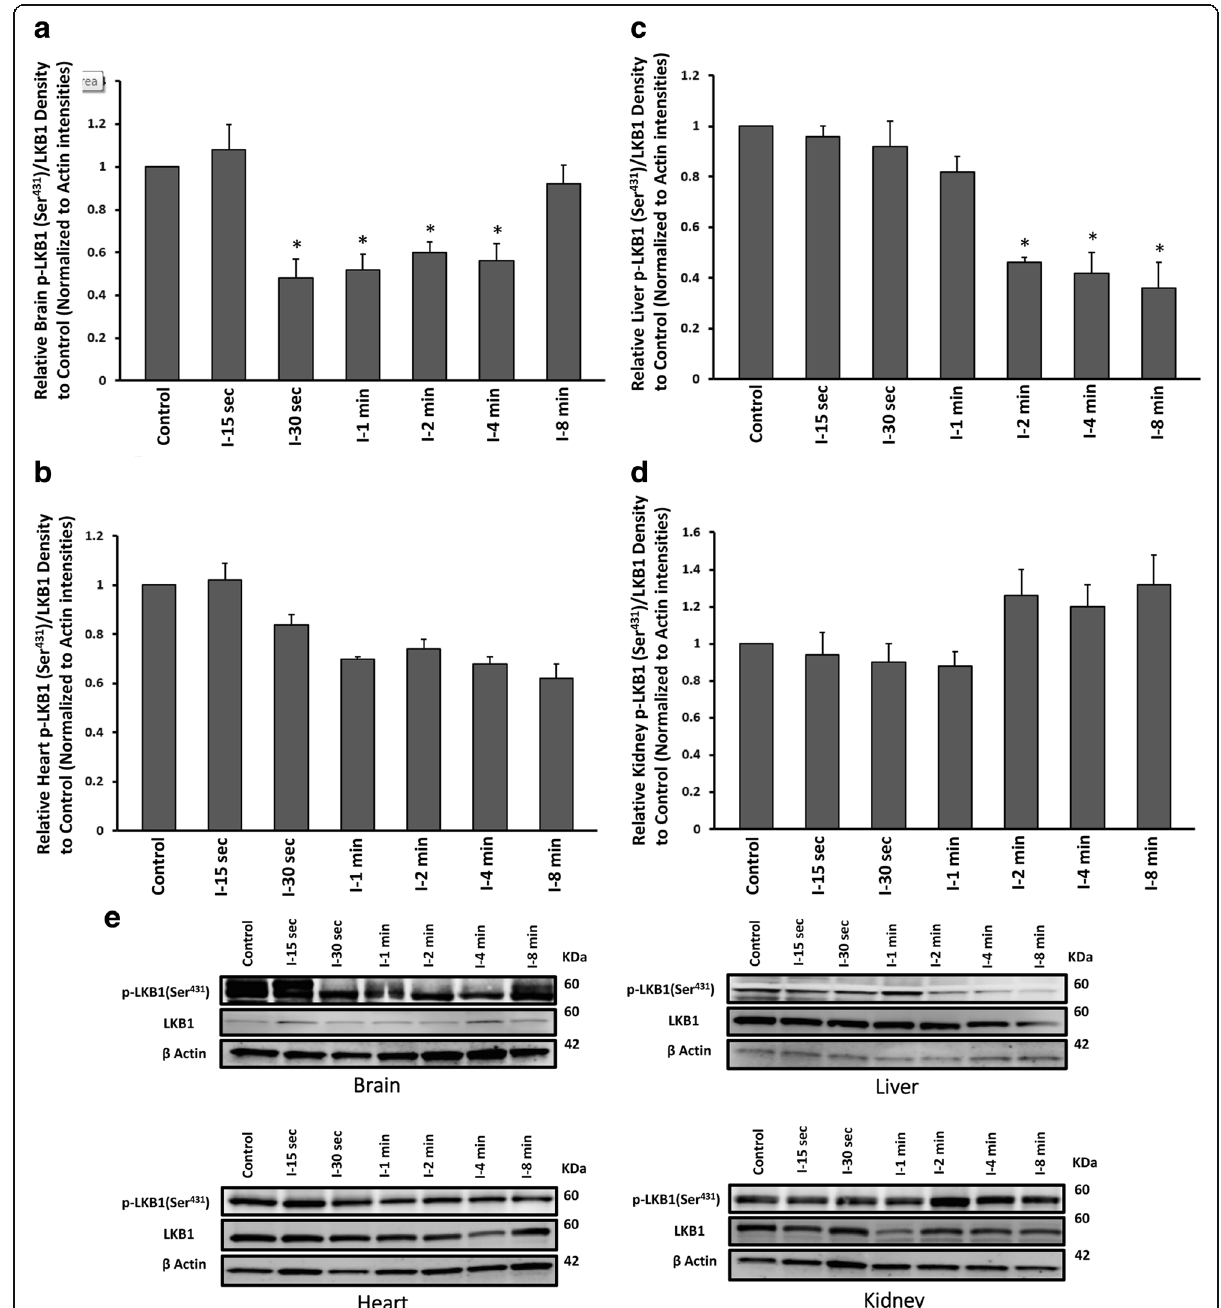
Fig. 3 Western blot analysis results of p-LKB1at Ser 431 and total protein of LKB1 assessment from a brain b heart c liver and d kidney tissues of ischaemic and control groups. All values are expressed as percent change relative to control group and were corrected by the Actin level. e Protein band intensities of p-LKB1 (Ser 431 ), LKB1 and Actin. I-15 s: 15 s ischemia, I-30 s: 30 s ischemia, I-1 min: 1 min ischemia, I-2 min: 2 min ischemia, I-4 min: 4 min ischemia, I-8 min: 8 min ischemia. * p <0.001 all groups vs control (One Way ANOVA, followed by post hoc Tukey ’ s). Error bars depict the